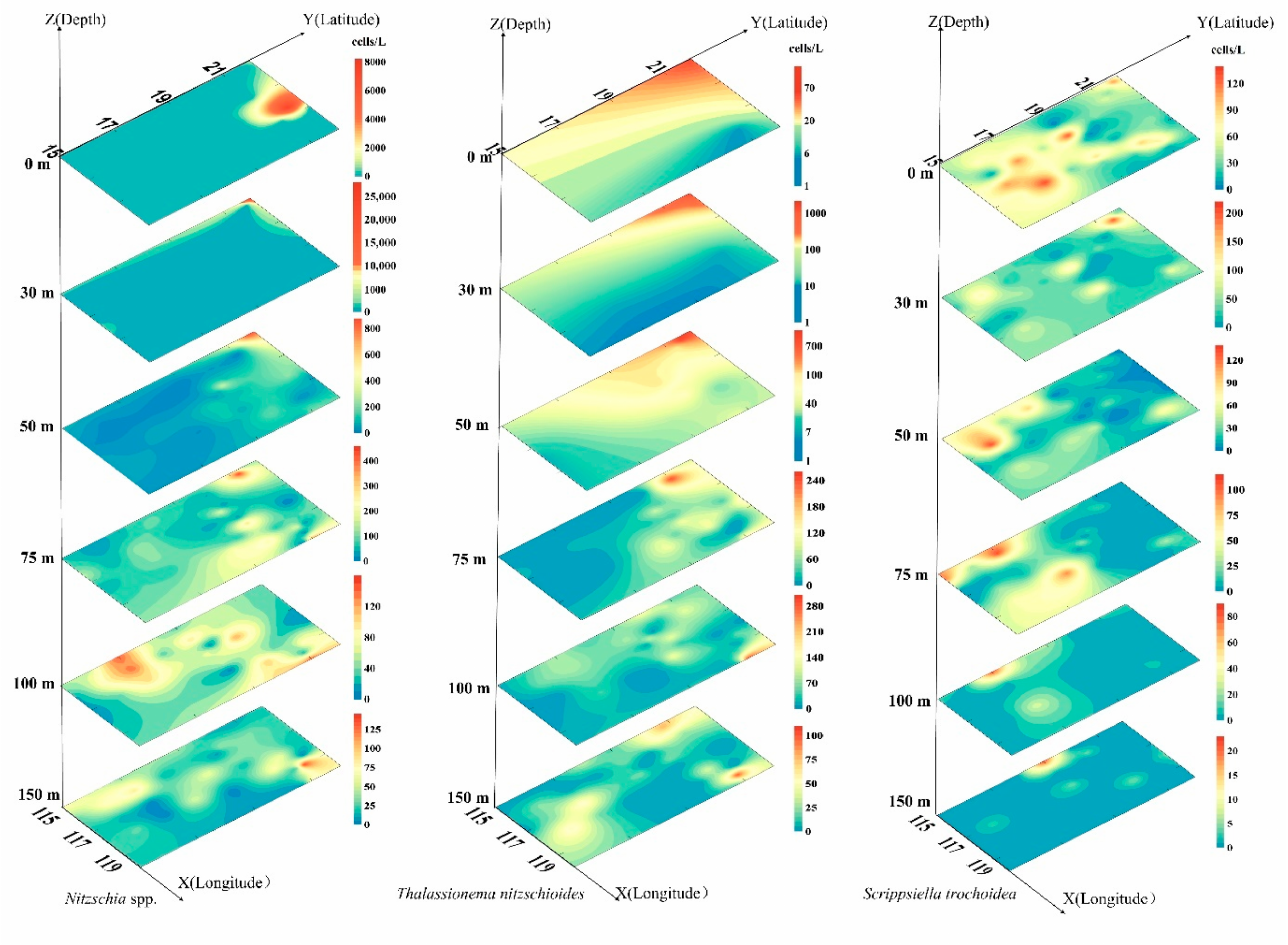
Figure 5. Horizontal distribution of the most dominant species in the sampling stations in the northern South China